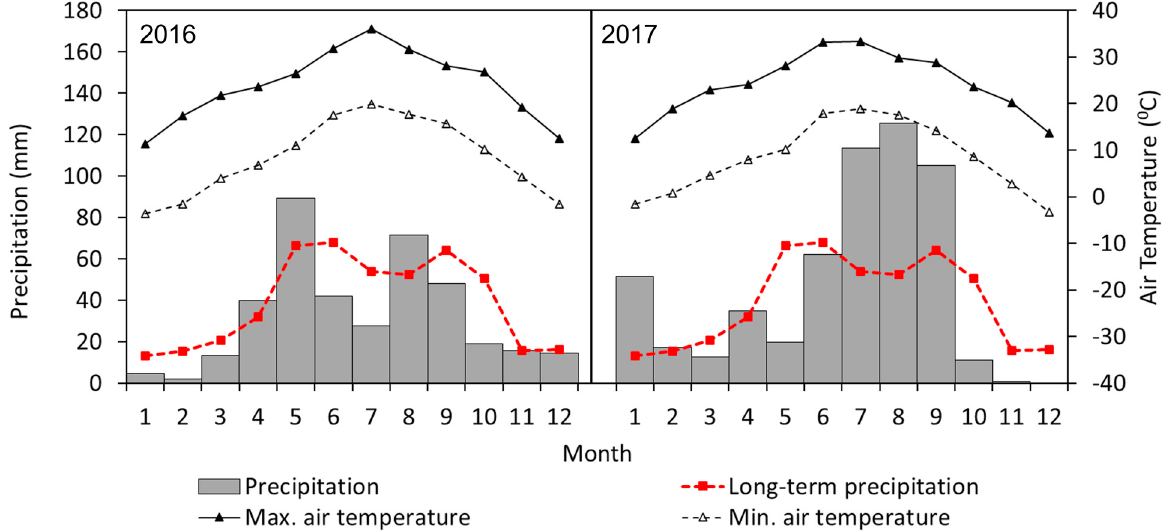
Figure 1. Monthly precipitation and maximum and minimum air temperatures from January 2016 to December 2017 at the study site, New Deal, Texas, USA. The red color line represents long-term (1911–2008) monthly average precipitation for the study area.